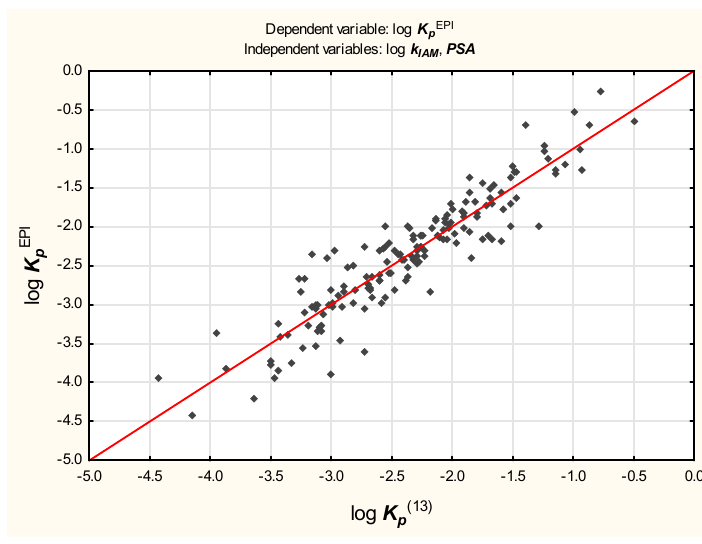
Figure 4. Equation (13)—reference vs. predicted log K p values.